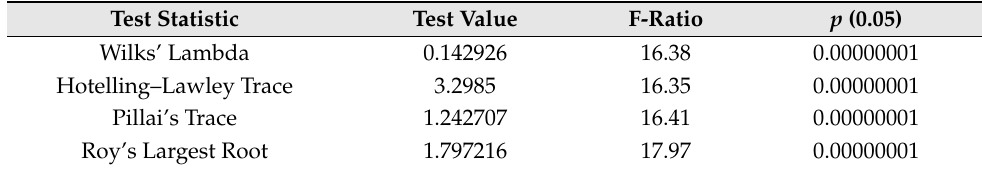
Table 5. MANOVA applied on taxa